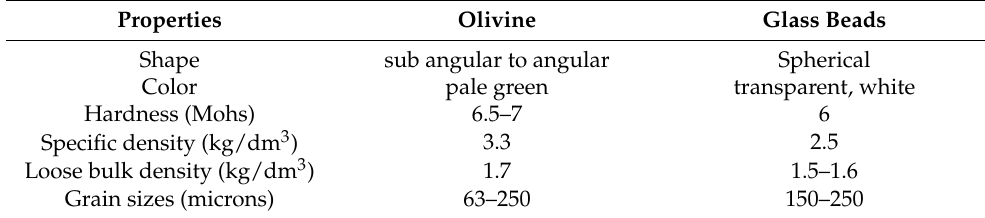
Table 3. Characteristics of abrasive materials.